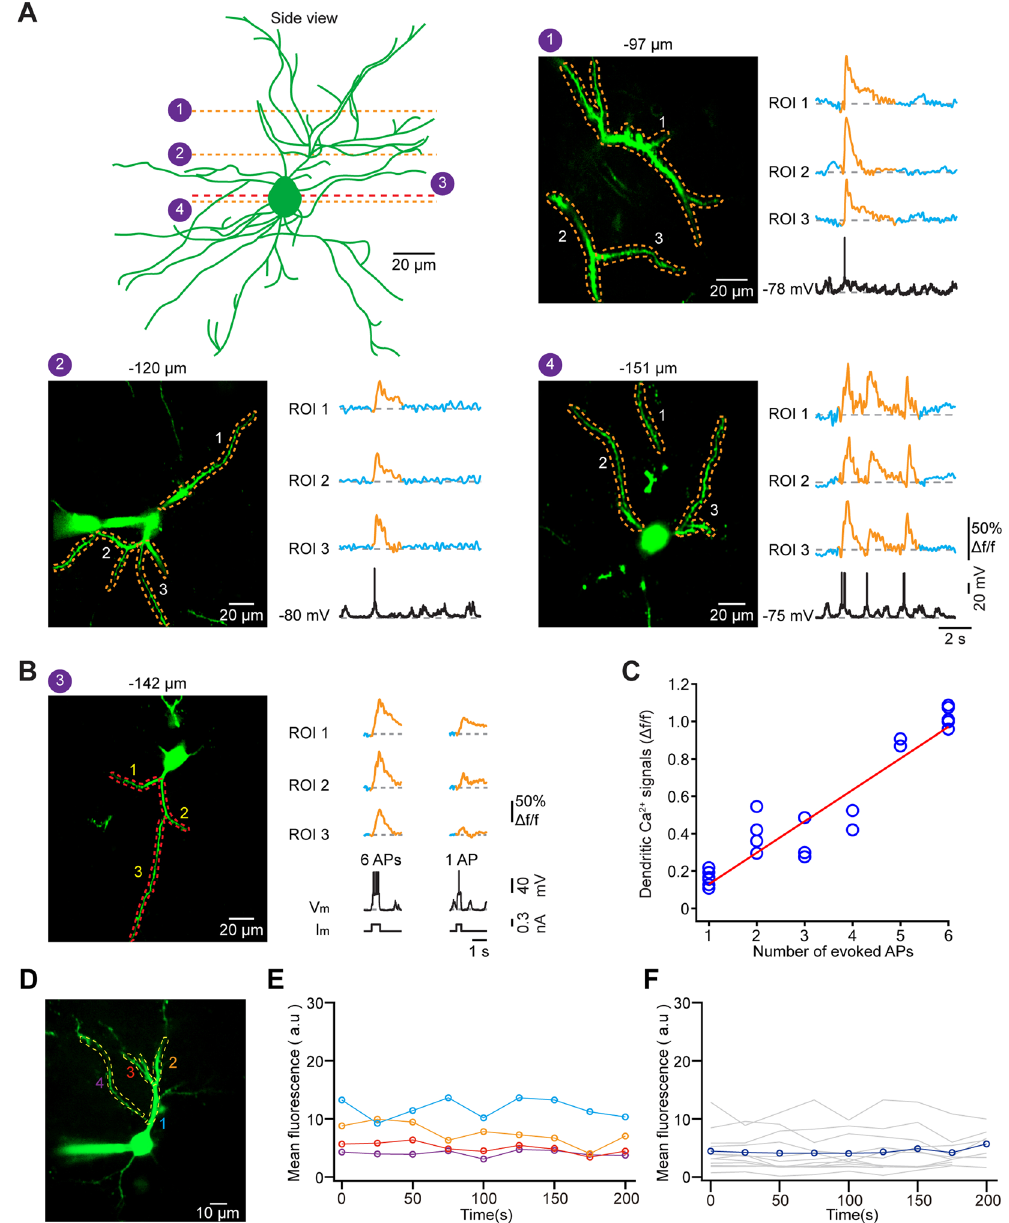
Figure 4. Global dendritic Ca 2 + signals associated with action potentials. ( A ) Upper left panel, side view of a recorded neuron, the same as in Fig. 3A. Four different planes of focus are indicated by dotted lines. Three other panels, dendritic Ca 2 + transients associated back-propagation action potentials (APs) in these three planes of this neuron. Each panel: left, two-photon image with regions of interest (ROIs); right, Ca 2 + transients ( Δ f/f) from the corresponding ROIs and the somatic electrical activity. ( B ) Ca 2 + transients from three ROIs during 6 APs and 1 AP that were evoked by current injections. Left, two-photon Ca 2 + image with ROIs. Right, Ca 2 + transients from these ROIs, and their corresponding membrane potentials (Vm) and current injections (Im). (C) Dependence of amplitude of dendritic Ca 2 + transients on the number of APs that were evoked by current injections. Each blue circle represents the result from one dendritic region of interest and the red line indicates a linear fit (R 2 = 0.861, P = 0.0048; n = 6 neurons) ( D ) Two-photon Ca 2 + image with four ROIs from another cell. (E) Mean fluorescence from these ROIs during a 200 s recording. (F) Mean fluorescence from 13 different dendritic regions of three